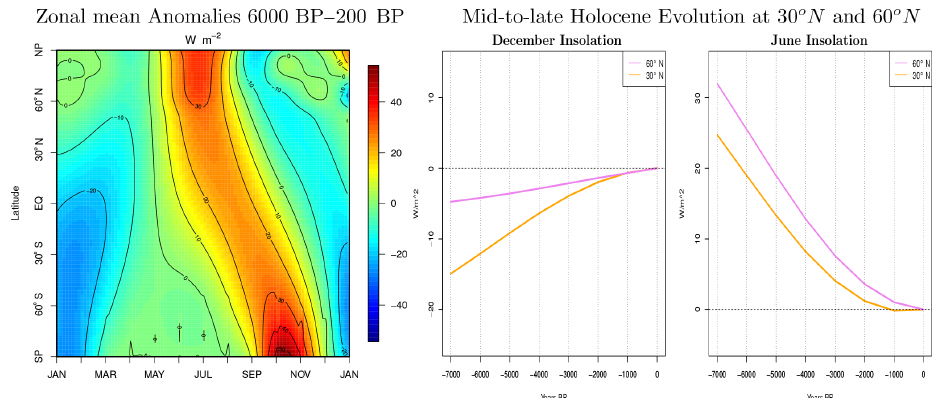
Figure 1. (Left) Anomalies of zonal mean insolation on top of the atmosphere (TOA) between 6000 years BP and pre-industrial period (PI). (Right) Mid-to-late Holocene trends of the anomalies, with respect to present-day values, of December and June TOA incoming insolation, calculated, according to Berger (1978), for 30 and 60 ◦ North. Units are Wm 2